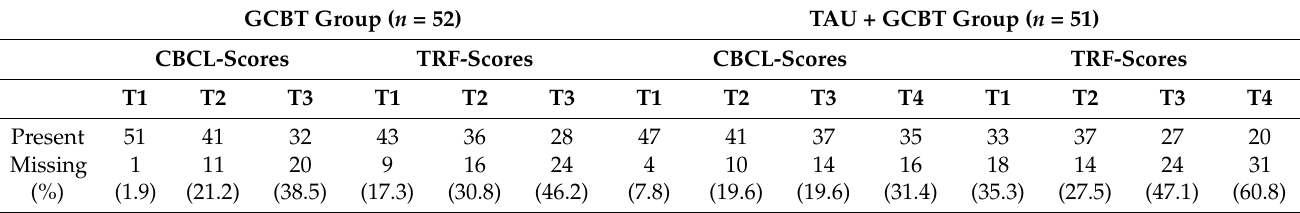
Table 2. Missing CBCL and TRF scores at the different time